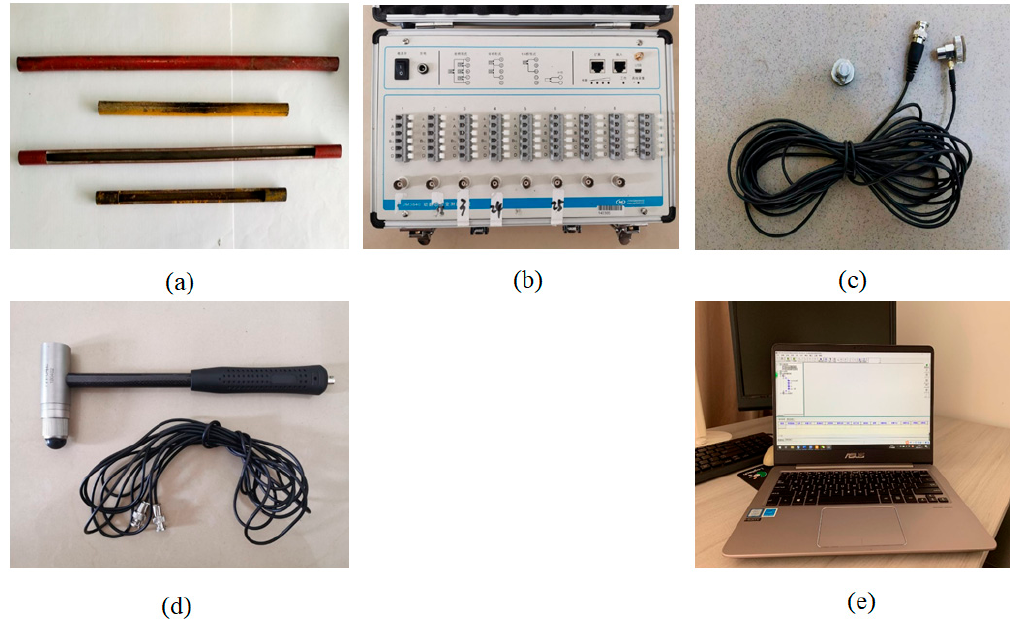
Figure 3. Experimental devices. ( a ) Intact and damaged rods, ( b ) acquisition instrument, ( c ) accelerometers, ( d ) hammer, ( e ) laptop.